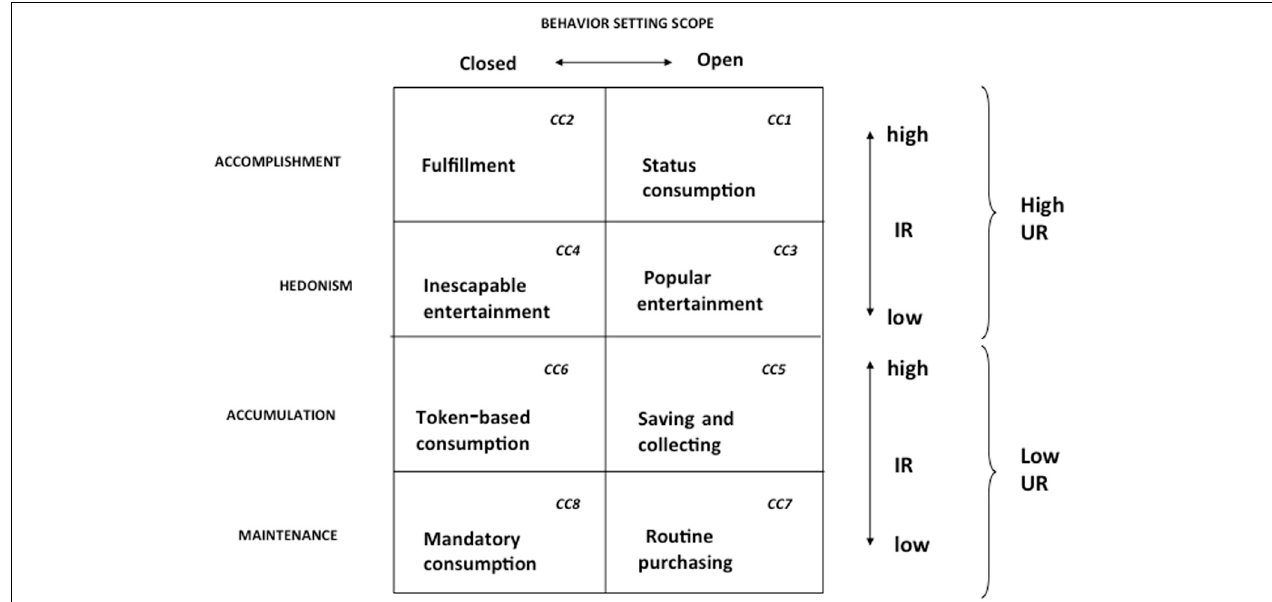
FIGURE 3 | The BPM contingency matrix. Adapted from Foxall (1990/2004). Used by permission. CC, Contingency